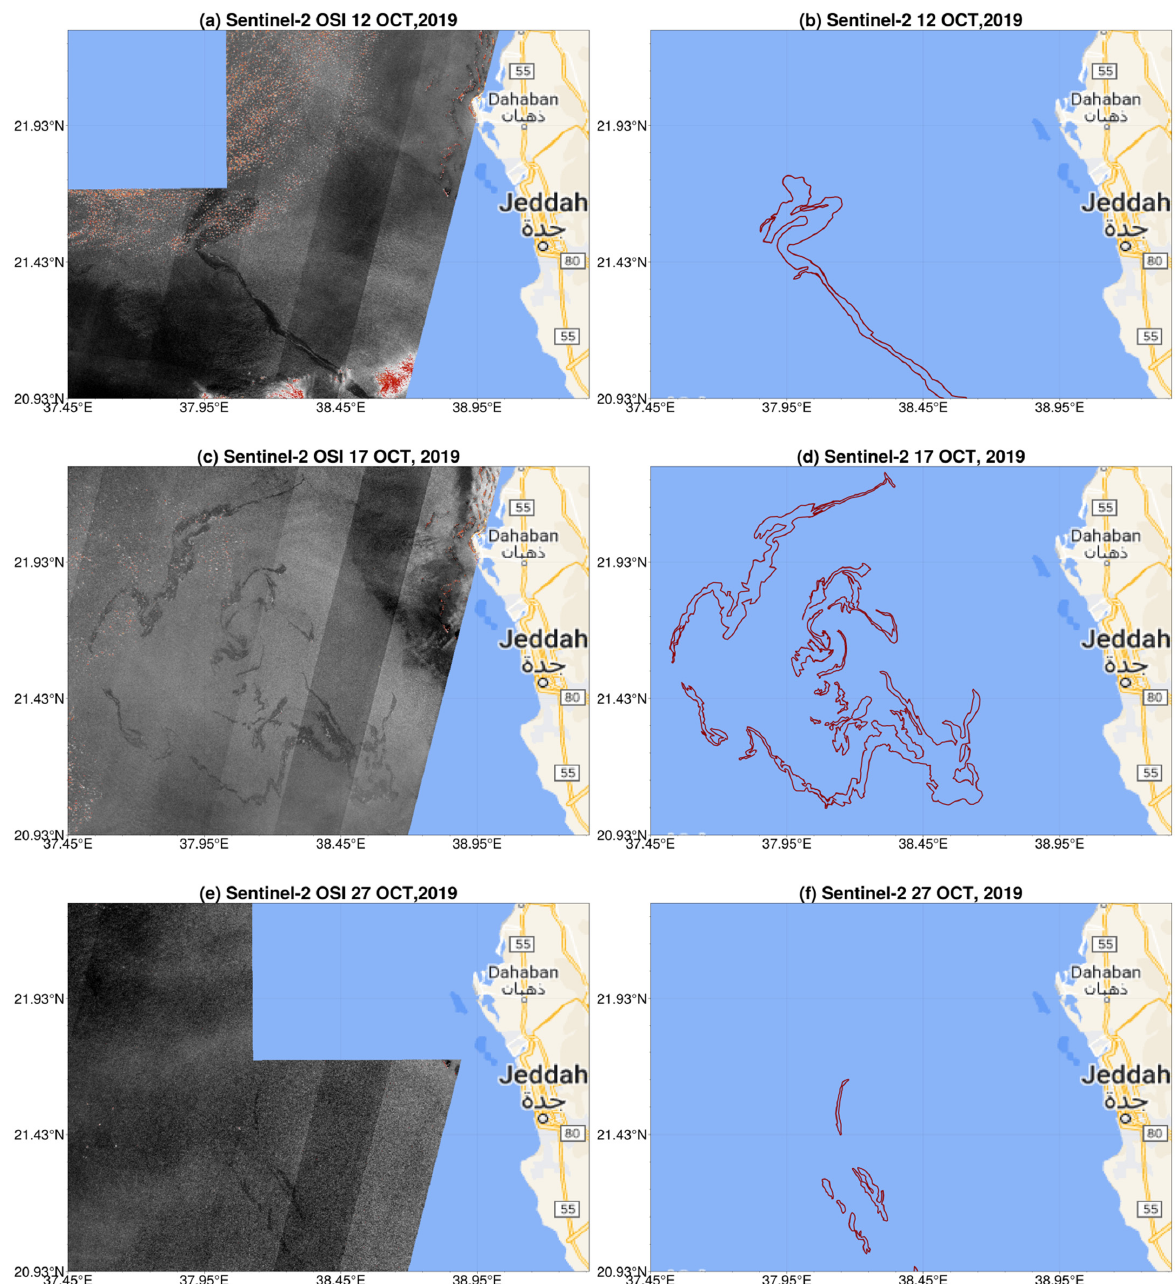
Figure 5. The Oil Spill Index (OSI) values of Sentinel-2 images on ( a ) 12 October 2019 (one day after the spill), ( c ) 17 October 2019 (7 days after the spill), ( d ) 27 October 2019 (17 days after the spill).